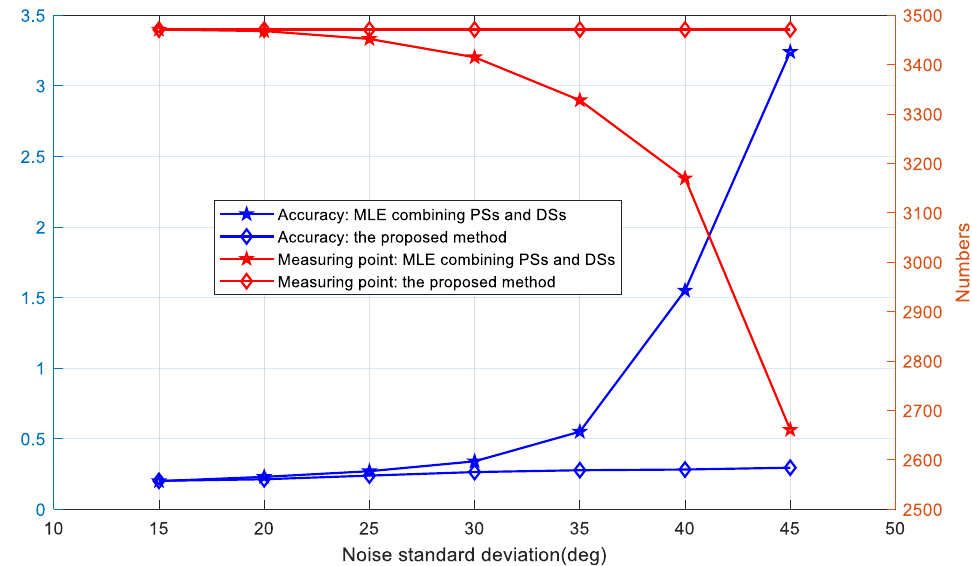
Figure 7. The performance comparison of the proposed method and MLE combining PSs and DSs.